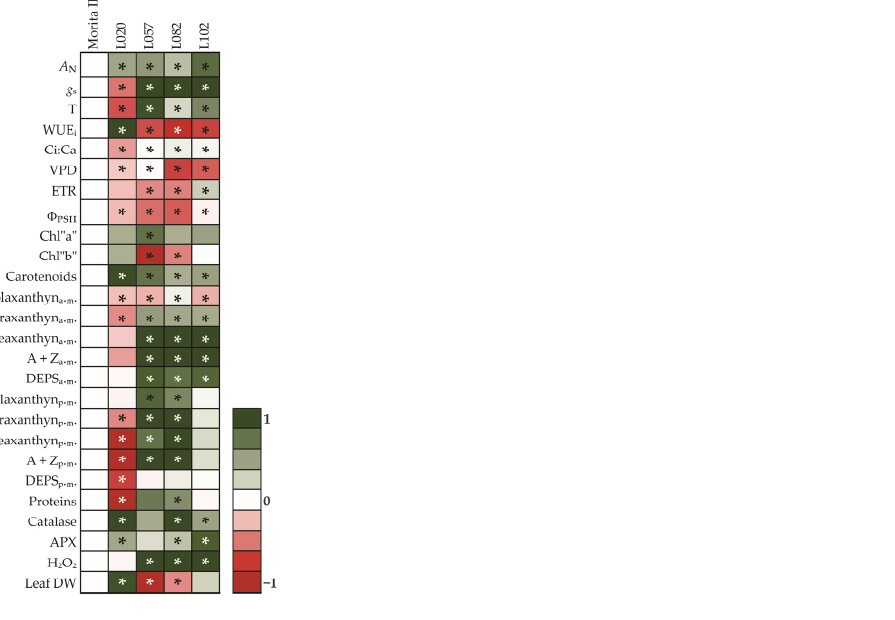
Figure 13. Heat map representing all analyzed features in genotypes of Stevia rebaudiana . The color code of the heat map is given at the log(2) scale. Data are normalized with respect to the mean response calculated for control (Morita II genotype). To allow statistical assessment, individual plants from this set were normalized in the same way. Values represent means ± SE (SNK; p ≤ 0.05) of five biological replicates. An asterisk (*) indicates that the values from other samples are significantly different from controls.